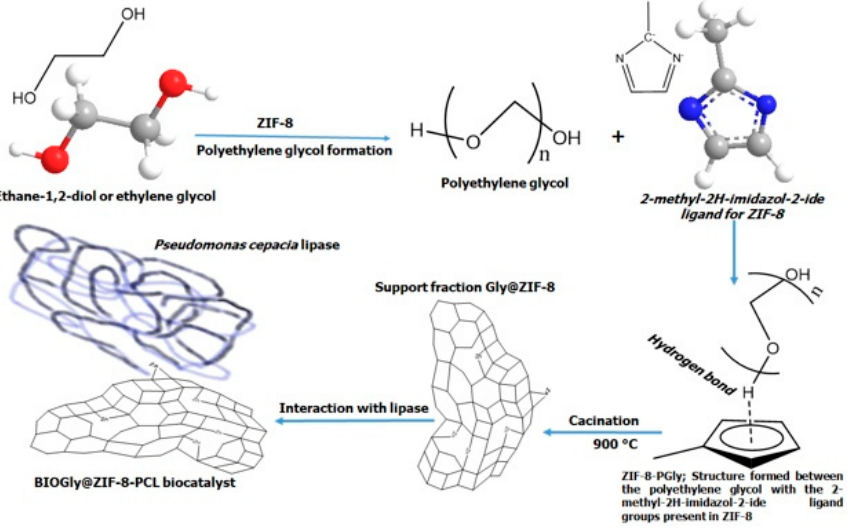
Figure 11. Route of formation of the biocatalyst BIOZIF-8-PCL, starting from the interaction of ZIF-8 with ethylene glycol and the formation of polyethylene glycol and ZIF-8-PGly as an intermediate.